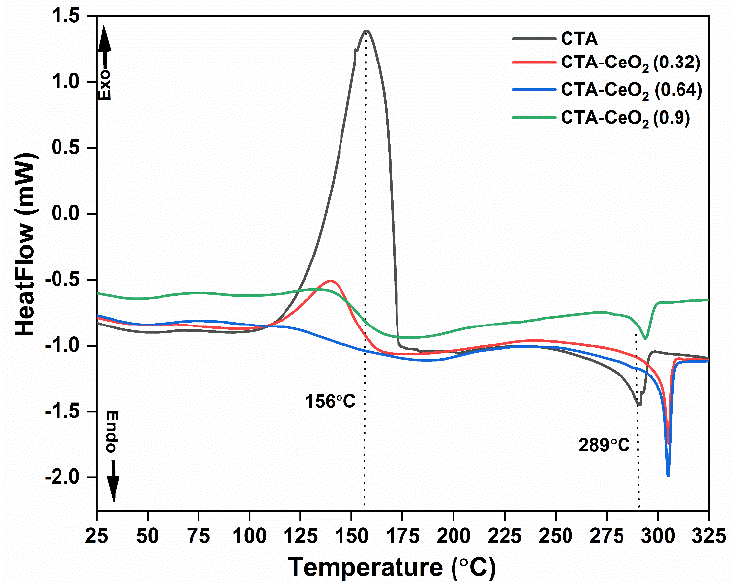
Figure 10. DSC thermogram of the pristine CTA and CTA-CeO 2 MMMs. The degree of crystallinity was evaluated from the melting enthalpy in the first scan of each sample. The melting temperature was taken as the peak of the melting endotherm from the first scan of each membrane. The heat of fusion/melting was calculated from the integrated area under the melting peak. The enthalpy of fusion decreases with the addition of CeO 2 nanoparticles: 7.31, 3.71, 4.53 and 2.05 Jg − 1 for CTA, CTA-CeO 2 (0.32), CTA-CeO 2 (0.64) and CTA-CeO 2 (0.9), respectively. This is indicative of a decrease in crystallinity. The degree of crystallinity ( ℵ ) of the modified membranes is calculated by the equation below: